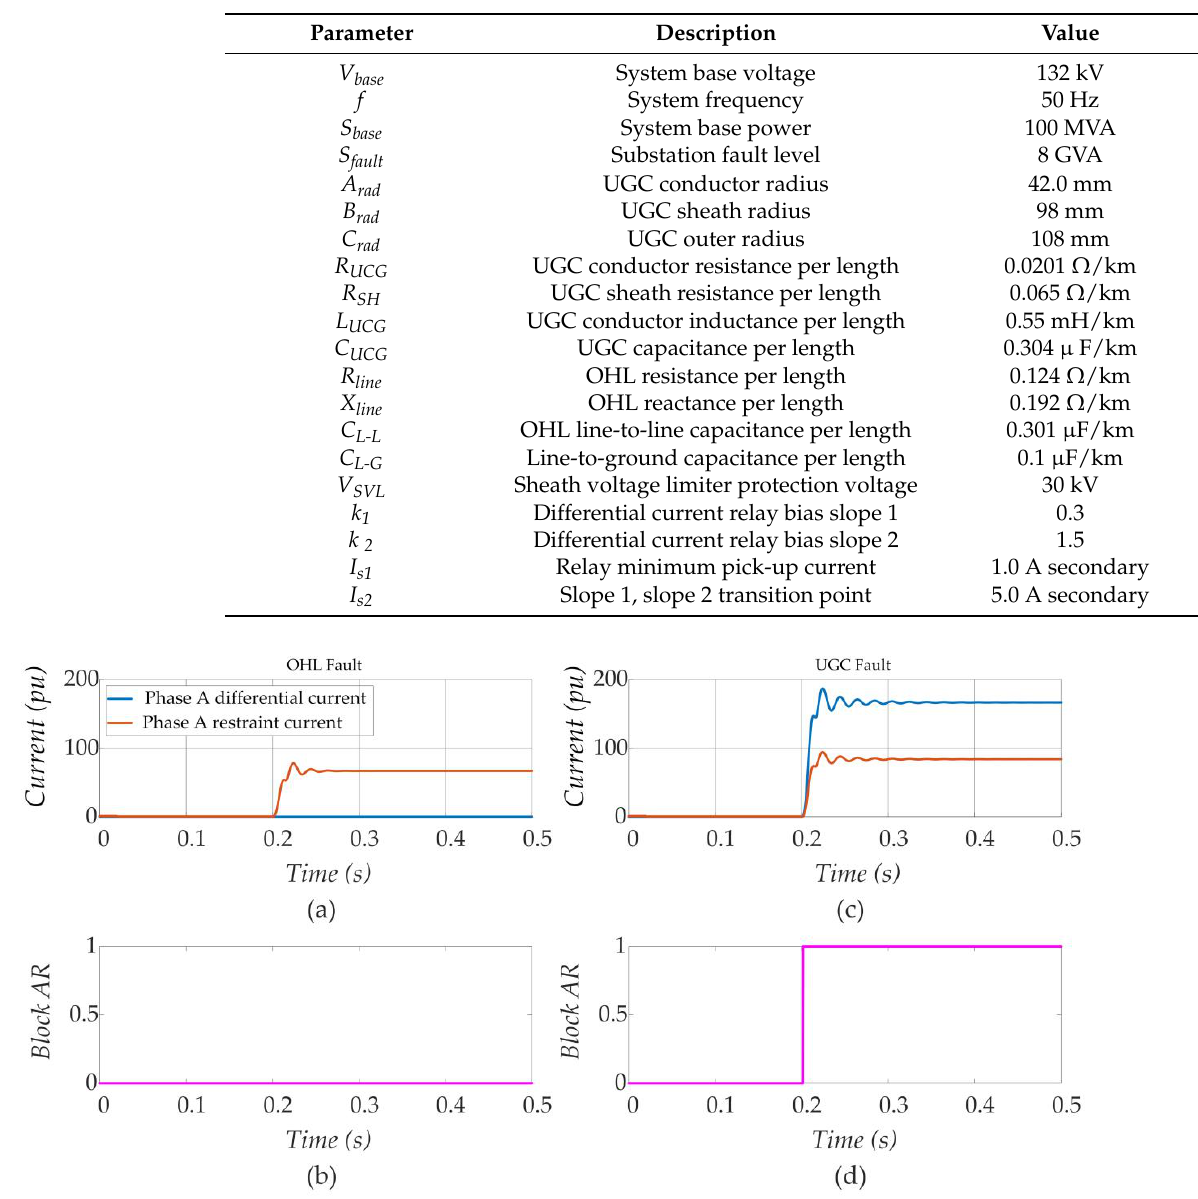
Table 1. Test System Parameters.